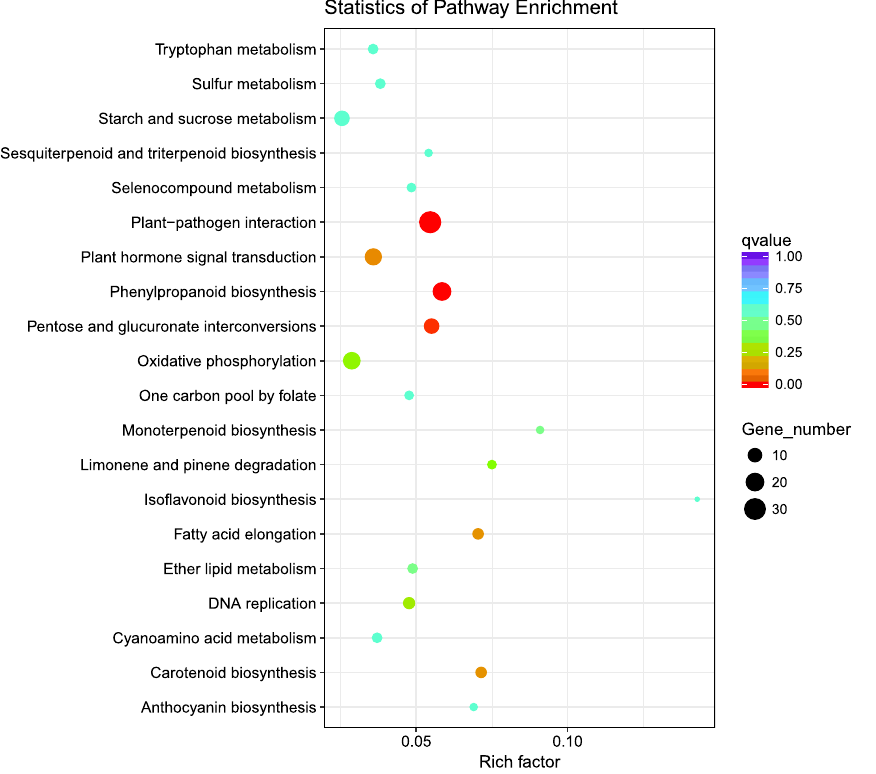
Figure 5. Statistic of pathway enrichment in KEGG of the DEG of SP versus